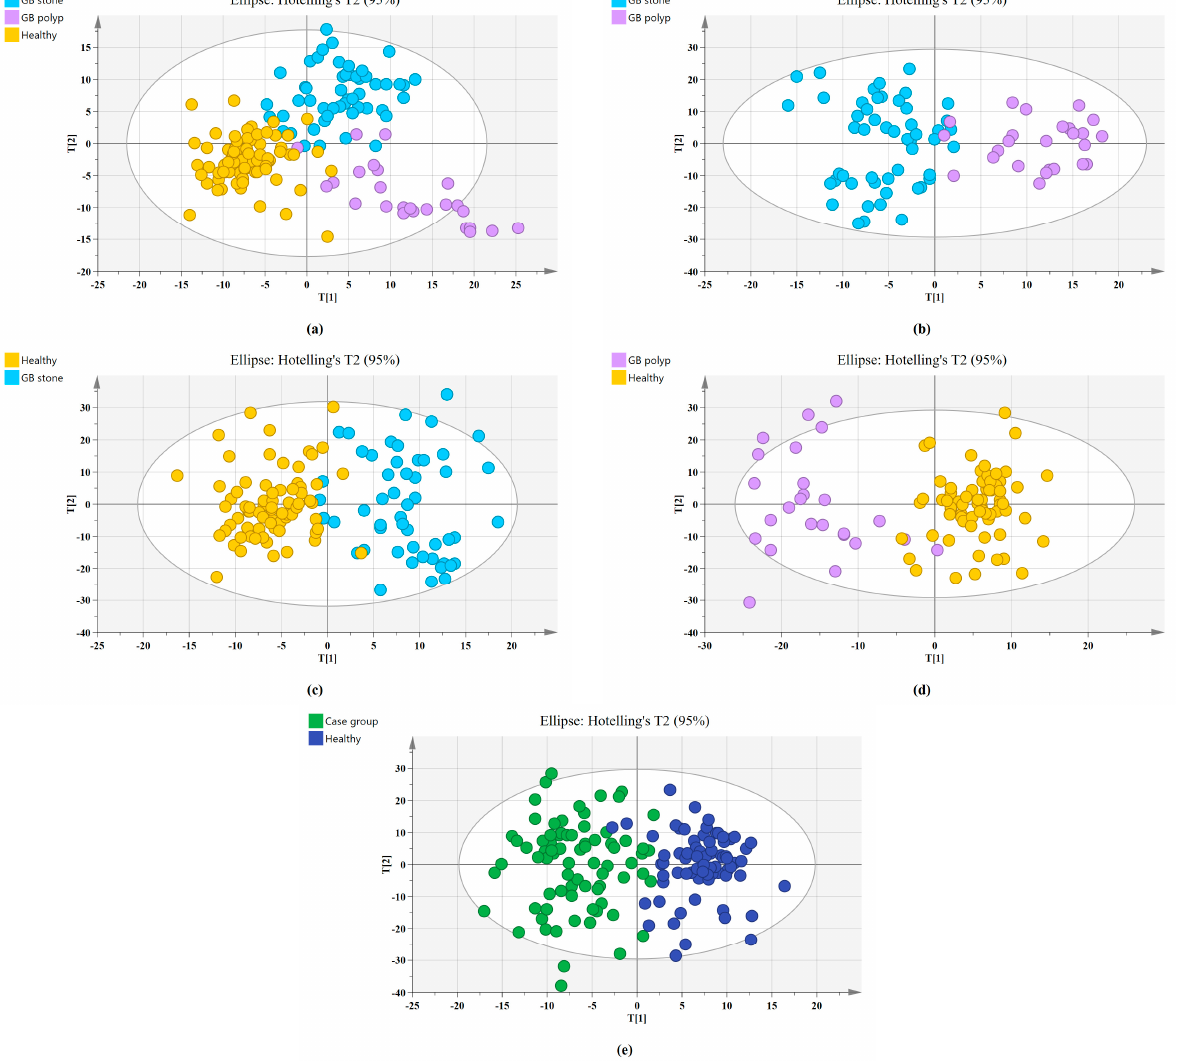
Figure 3. Principal component score plots of the SERS spectra based on OPLS-DA. ( a ) Score plot for Healthy, GB stone, and GB polyp serum samples. ( b ) Score plot for GB stone, and GB polyp serum samples. ( c ) Score plot for Healthy, and GB stone serum samples. ( d ) Score plot for Healthy, and GB polyp serum samples. ( e ) Score plot for Healthy, and Case group* serum samples. (*Case group, GB stone, and GB polyp Group).